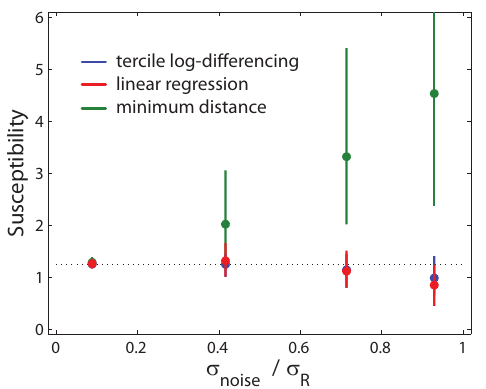
Fig. A4. Susceptibility estimates from TLD (blue), linear regres- sion (red), and minimum distance (green) with increasing threshold level. Dots represent mean susceptibility from 100 estimates and the lines show middle 95% interval. The abscissa shows the ratio between the threshold value and the mean, µ R , of R after applying the threshold. The dotted line represents the underlying β value.